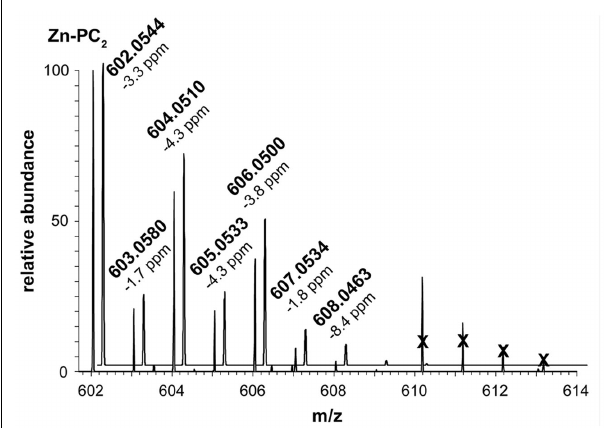
FIGURE 9 | Measured (front) and simulated spectrum (back) isotopic pattern at m / z 602–614. Isotopic pattern of Zn ( 64 Zn 48.6; 66 Zn 27.9; 67 Zn 4.1; 68 Zn 18.8; 70 Zn 0.6%) and PC 2 is shown at m / z